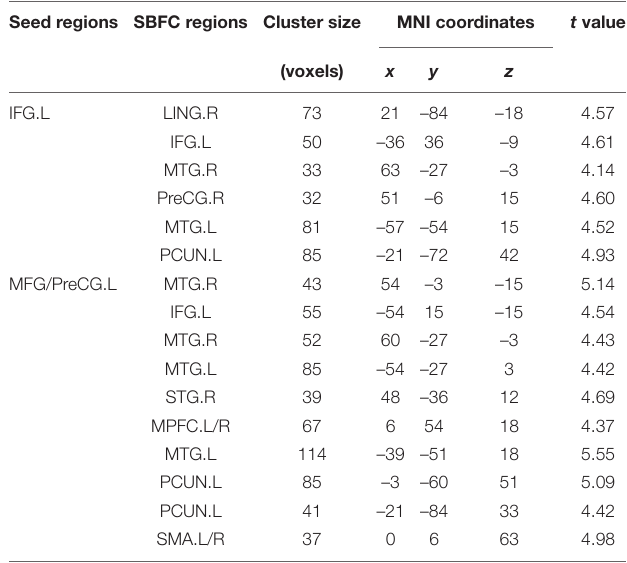
TABLE 2 | Brain regions showing correlations between the SBFC and ES. The t value refers to the statistical difference in a region. Seed regions SBFC regions Cluster